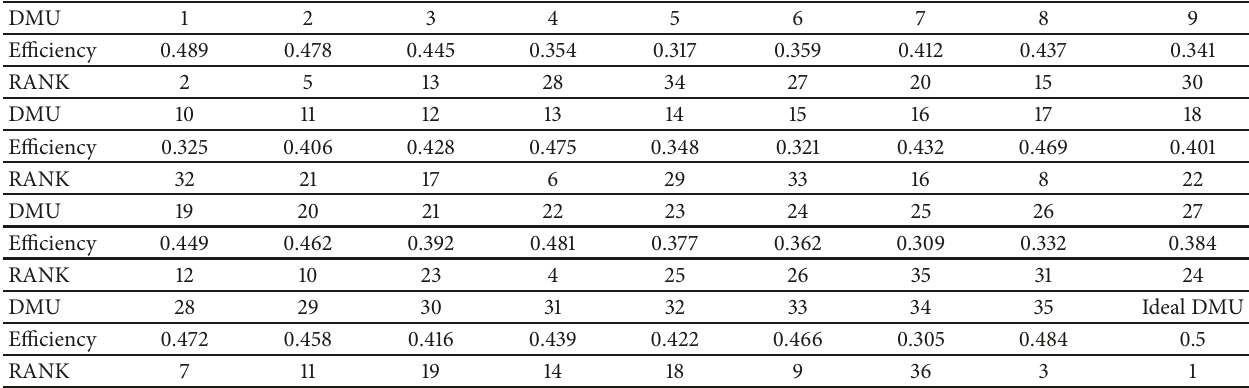
Table 10: Evaluating suppliers along with the ideal supplier (Model RI b